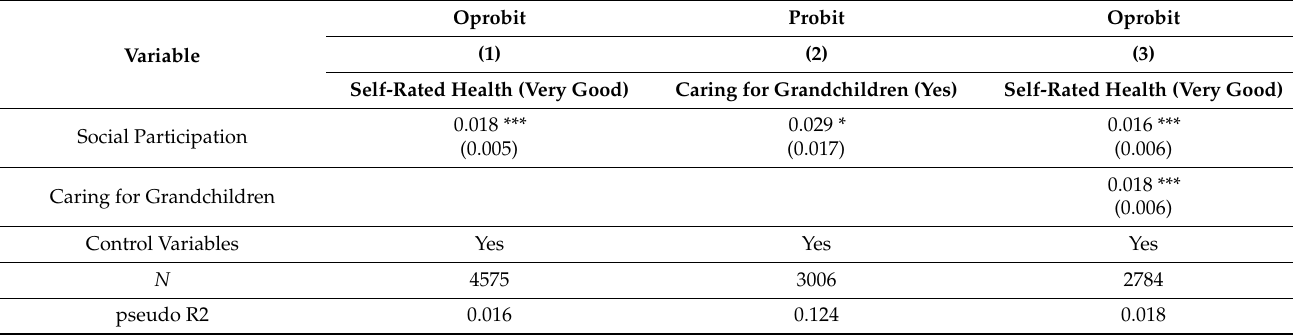
Table 6. The mediating effect of caring for grandchildren